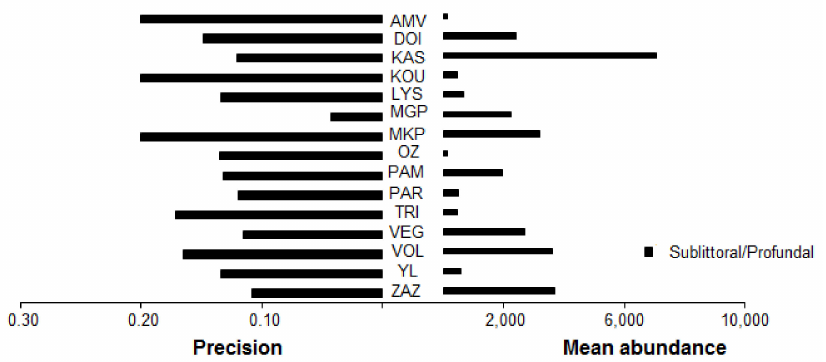
Figure 4. Mean abundance of benthic macroinvertebrates and precision (P) for the sublit- toral/profundal zone.